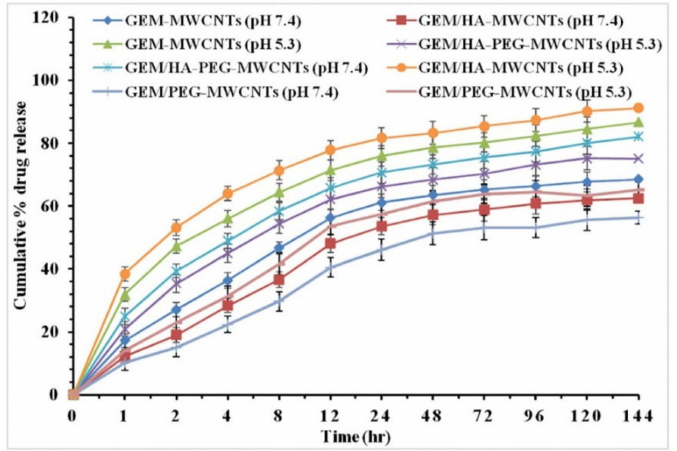
Figure 7. In vitro drug release profiles of GEM-MWCNTs, GEM/HA-MWCNTs, GEM/PEG- MWCNTs, and GEM/HA-PEG-MWCNTs at phosphate buffer (pH 7.4) and lysosomal conditions (pH 5.3). Reprinted with permission from Ref. [49]. Copyright 2019